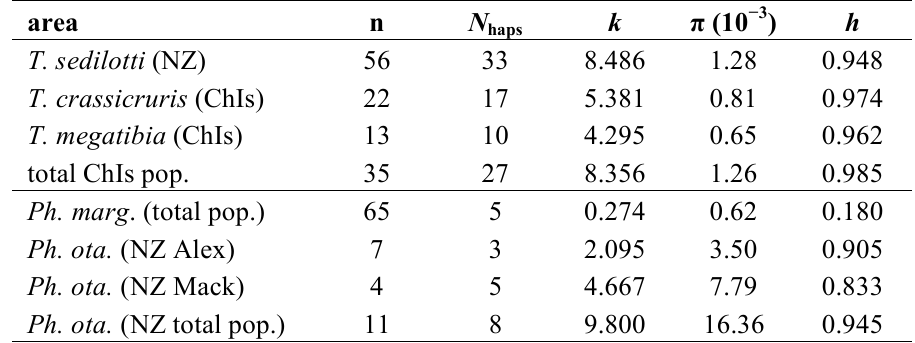
Table 2. DNA variation and haplotype diversity within and between regional samples of Talitropsis and Phaulacridium in the New Zealand region, with the sample size for each region (n), number of observed haplotypes ( N ), average number of nucleotide haps differences ( k ), nucleotide diversity ( π ) and haplotype diversity ( h ). Abbreviations represent region as follows: NZ = mainland New Zealand; ChIs = Chatham Islands; NZ Alex = P. otagoense population in Alexandra, Otago; NZ Mack = P. otagoense population in Mackenzie,